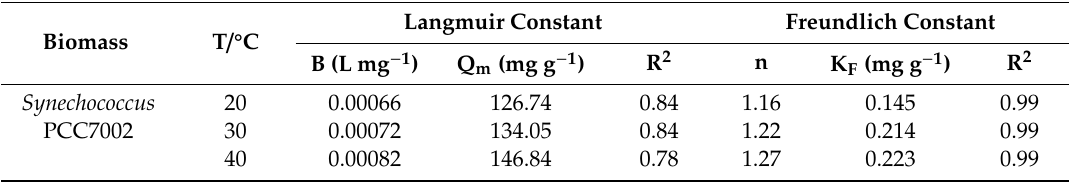
Figure 4. Langmuir isotherms ( a ) and Freundlich isotherms ( b ) of Cs(I) adsorption on Synechococcus PCC7002. Table 1. Kinetic parameters for the biosorption of Cs(I) onto Synechococcus PCC7002. Table 2. Comparison of the Langmuir and Freundlich constants obtained from adsorption isotherms of Cs(I).